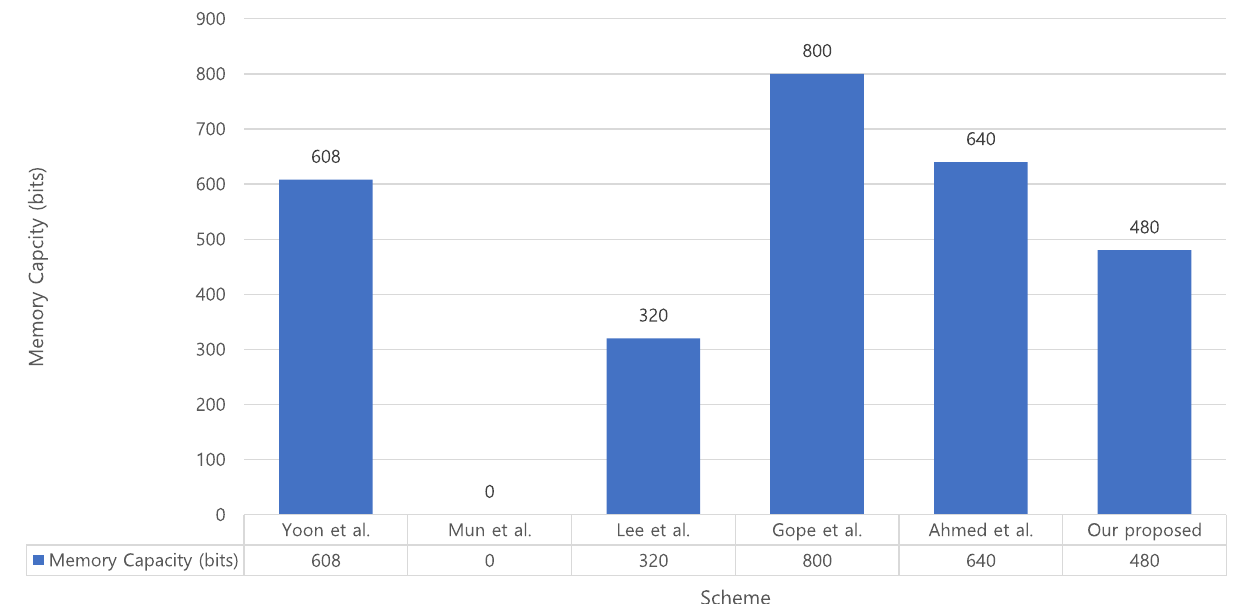
Fig 23. Comparison of memory capacity of the smartcard in our proposed scheme with those of existing schemes. https://doi.org/10.1371/journal.pone.0247441.g023 PLOS ONE | https://doi.org/10.1371/journal.pone.0247441 February 26,